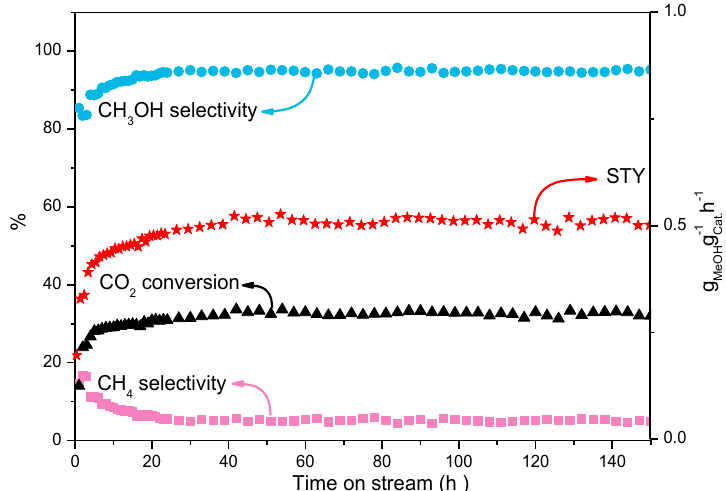
Figure 6. Stability of the MoS 2 -45@C catalyst with granule stacking.